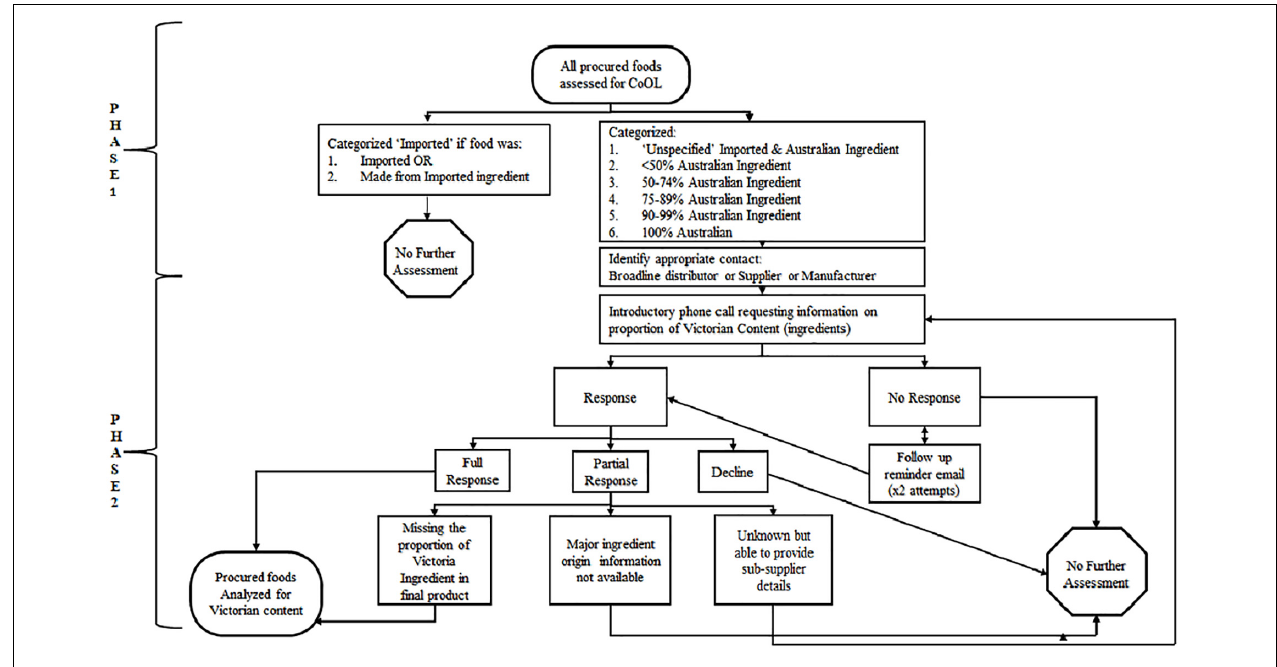
FIGURE 1 | Participant recruitment process. TABLE 1 | Food group category